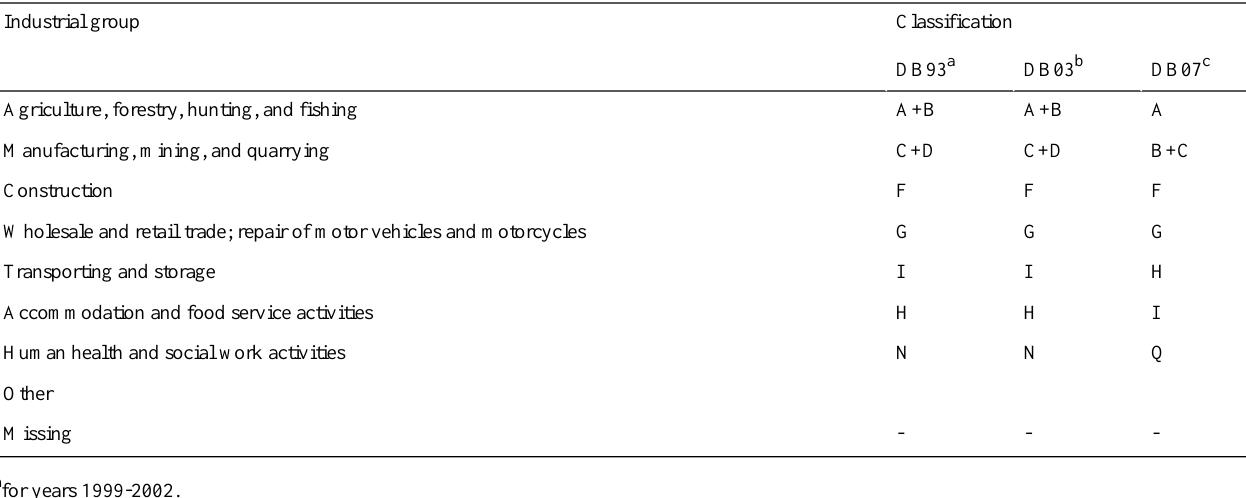
Table 1. Industrial groups coded according to the subclassifications within the main classifications of DB93, DB03, and DB07. ClassificationIndustrial